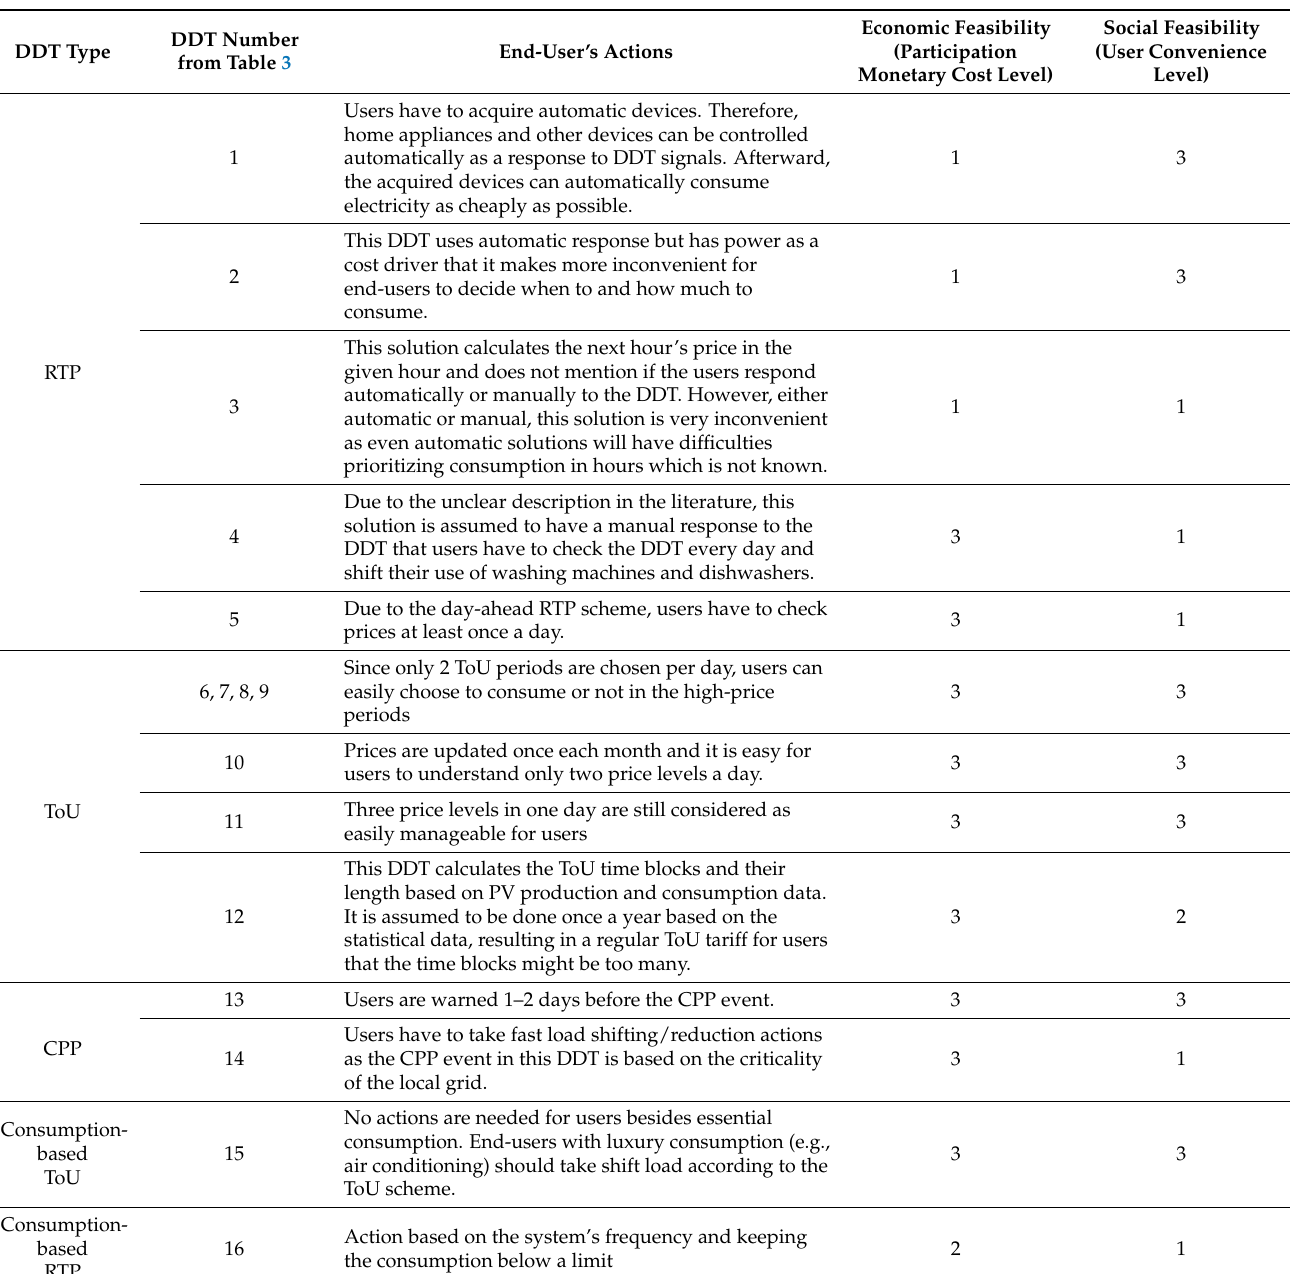
Table 7. Economic and social feasibilities for each